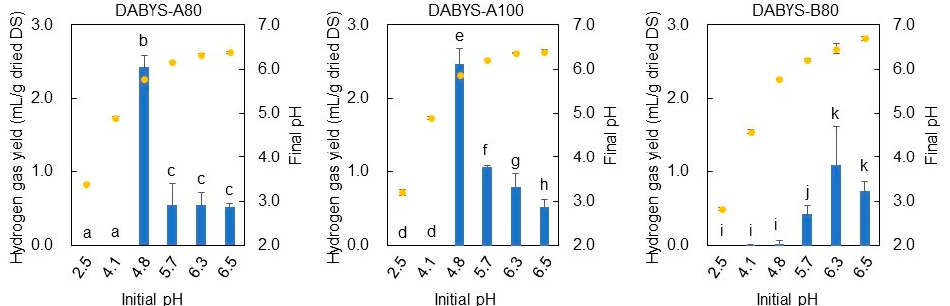
Figure 6. Influence of the initial pH on the hydrogen gas-producing activity of DABYS-A80, -A100, and -B80 (blue columns), and the final pH (yellow dots) after the 1-month dark fermentation. The data are presented as the mean ± standard deviation of independent triplicates. The letters above the columns indicate significant differences at p < 0.05 (Student’s t -test).